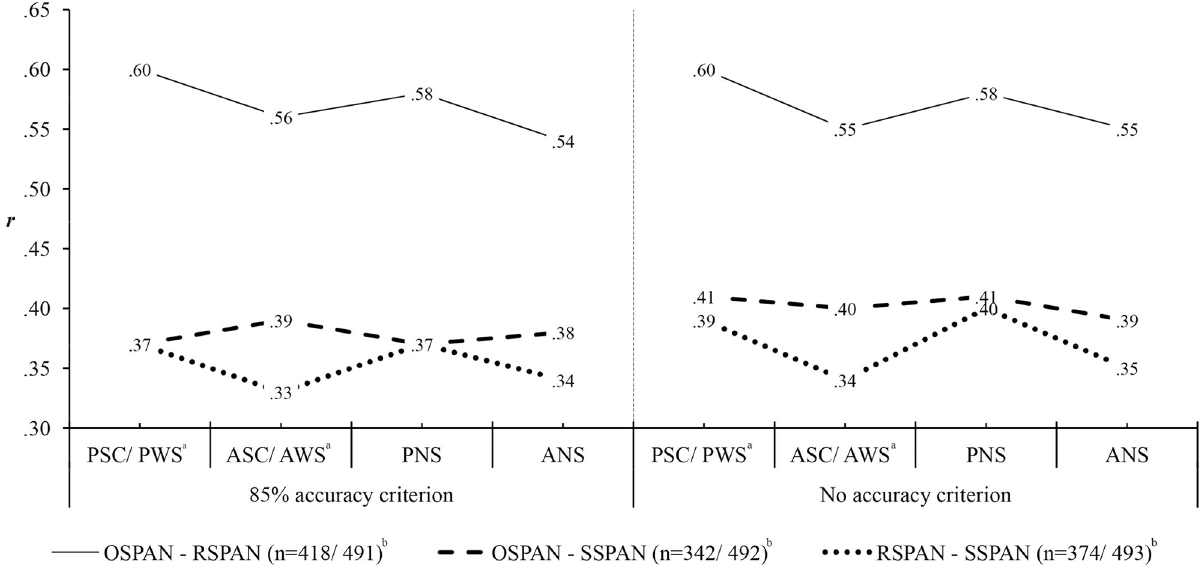
Fig 1. Correlations among equivalent working memory capacity (WMC) scores of different working memory (WM) span tasks according to the accuracy criterion on the processing component of the tasks. All p s < .001. OSPAN = operation span; RSPAN = reading span; SSPAN = symmetry span; PSC = partial score; ASC = absolute score; PNS = partial non-weighted score; ANS = absolute non-weighted score; PWS = partial weighted score; AWS = absolute weighted score. a As PWS is a simple linear transformation of PSC, their intercorrelation is maximal ( r = 1), and their correlations with other measures are identical. The same holds for AWS and ASC. b Size of the subsample of participants above the 85% accuracy criterion/ size of the full sample with no accuracy